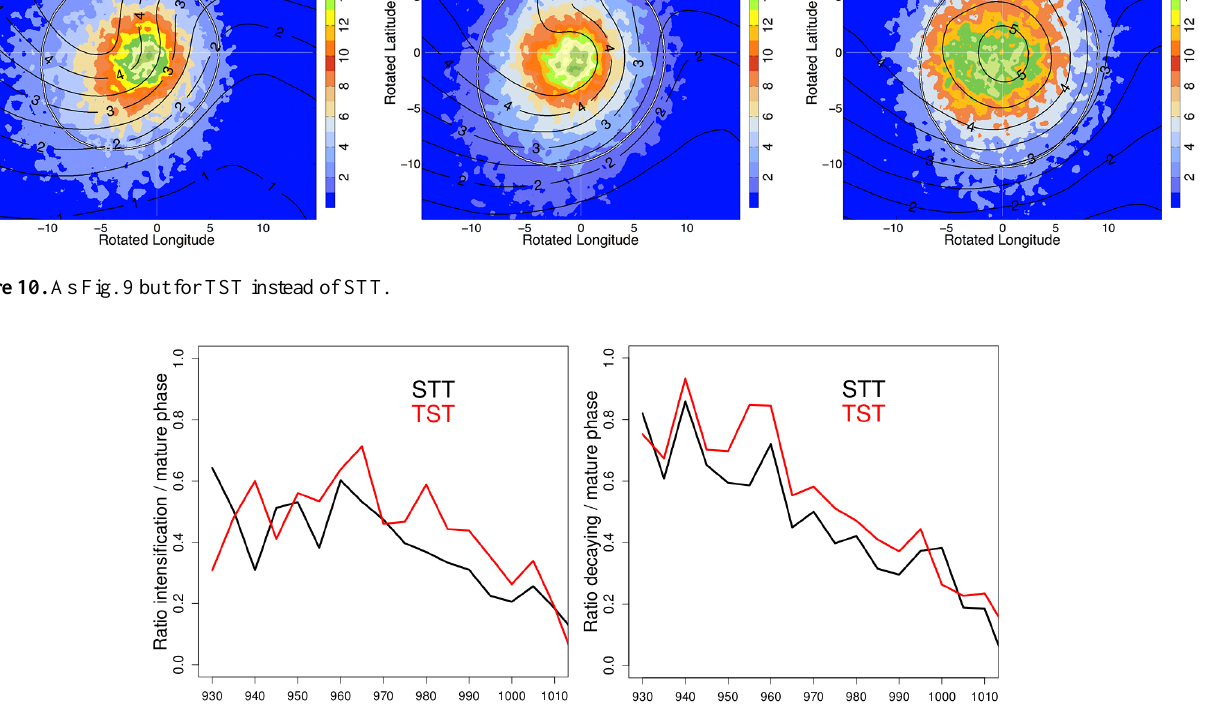
Figure 11. Ratio between the exchanged mass during the intensification and the mature phase (left) and between the decaying and mature phase (right) for STT (black) and TST (red) as a function of the cyclone’s minimum SLP (only for winter). The ratio is calculated using the median from the box and whisker plots of Figs. 9 and 10. Note, results are presented here up to 1010hPa due to the low number of cyclones for higher minimum